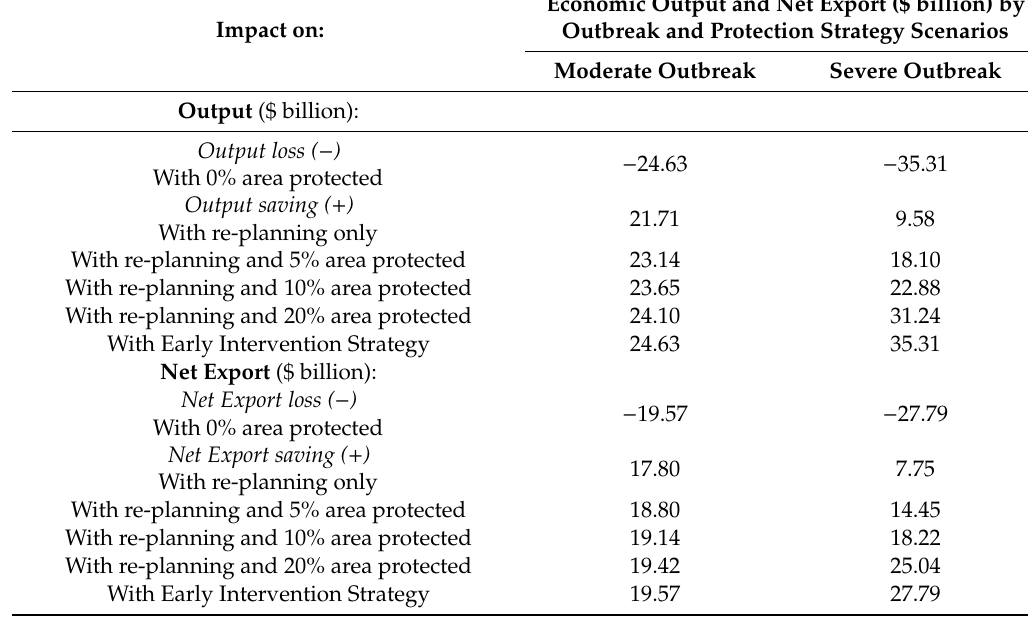
Figure 2. Projected relative stumpage revenue from all Crown land harvest in New Brunswick from 2010 to 2060 under ( a ) moderate and ( b ) severe SBW outbreak and protection scenarios. Table 2. Current value a output and net export impacts, cumulative from 2010 to 2060, for moderate and severe spruce budworm outbreak scenarios on Crown land in New Brunswick.